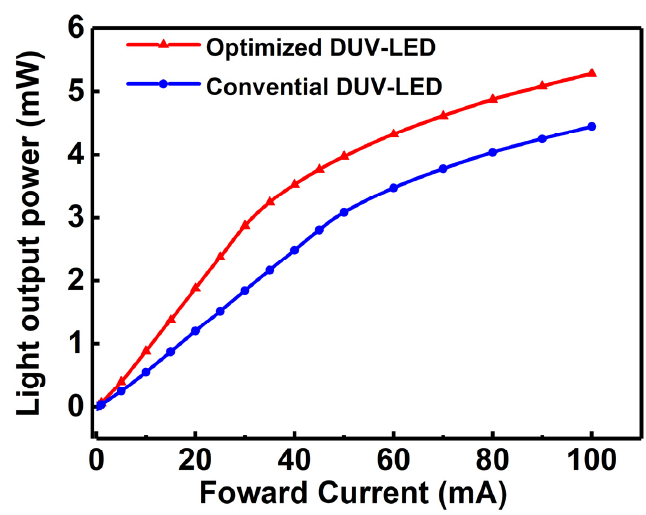
Figure 12. Measured light output values of the DUV-LEDs packaged through conventional and proposed packaging versus forward current methods plotted against forward current.